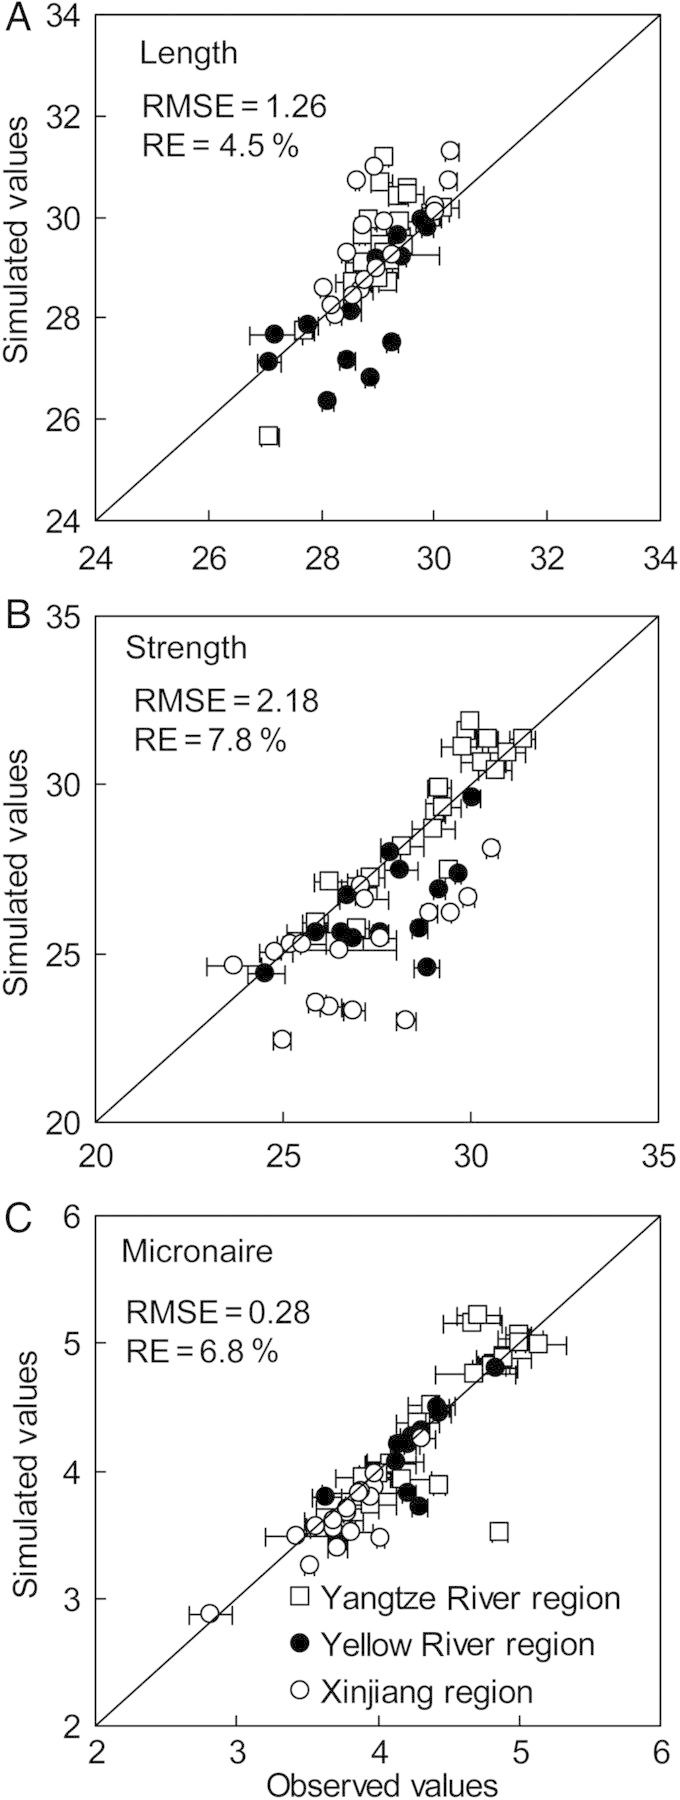
Comparison of observed and simulated cotton fibre length (A), strength (B) and micronaire (C) from 2006 to 2011 for 11 sites in major cotton producing regions in China. In the simulations, sowing dates were 10 April, 25 April and 15 April in Xinjiang, Yellow River and Yangtze River regions, respectively. The time of main stem topping was 10 July in the north part and 20 July in the south part of Xinjiang region, and 30 July in Yellow River and Yangtze River regions. Branch topping time was 15 days after topping of the main stem in all cases.